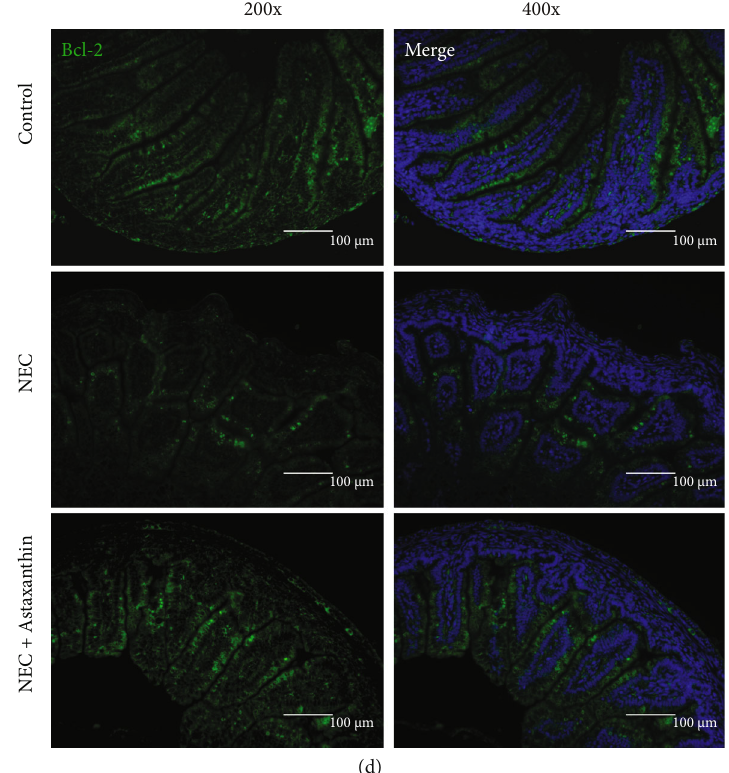
Figure 3: Astaxanthin reduced the expression of Bcl-2-associated X (BAX) while enhanced the expression of B-cell lymphoma-2 (Bcl-2) of intestinal tissues in NEC rats. (a, b, c, and d) Immuno fl uorescence staining was used to test Bcl-2, BAX expressions of intestinal tissues in rats. Magni fi cation × 200, 400, n = 6 in each group; ▲▲ P < 0 : 01 vs. control group. ★★ P < 0 : 01 vs. NEC